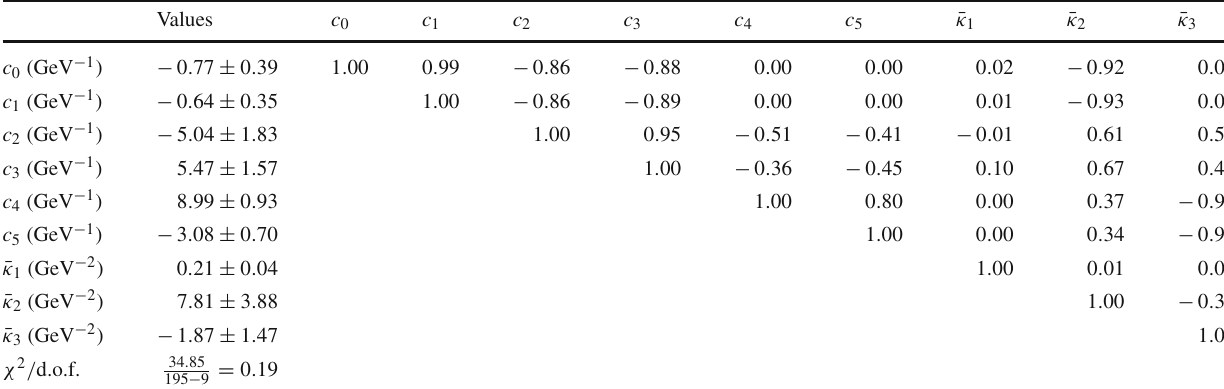
Table 1 Results of fitting to various lattice data of the phase shifts and scattering lengths. For a detailed description, see the main text Values c 0 c 1